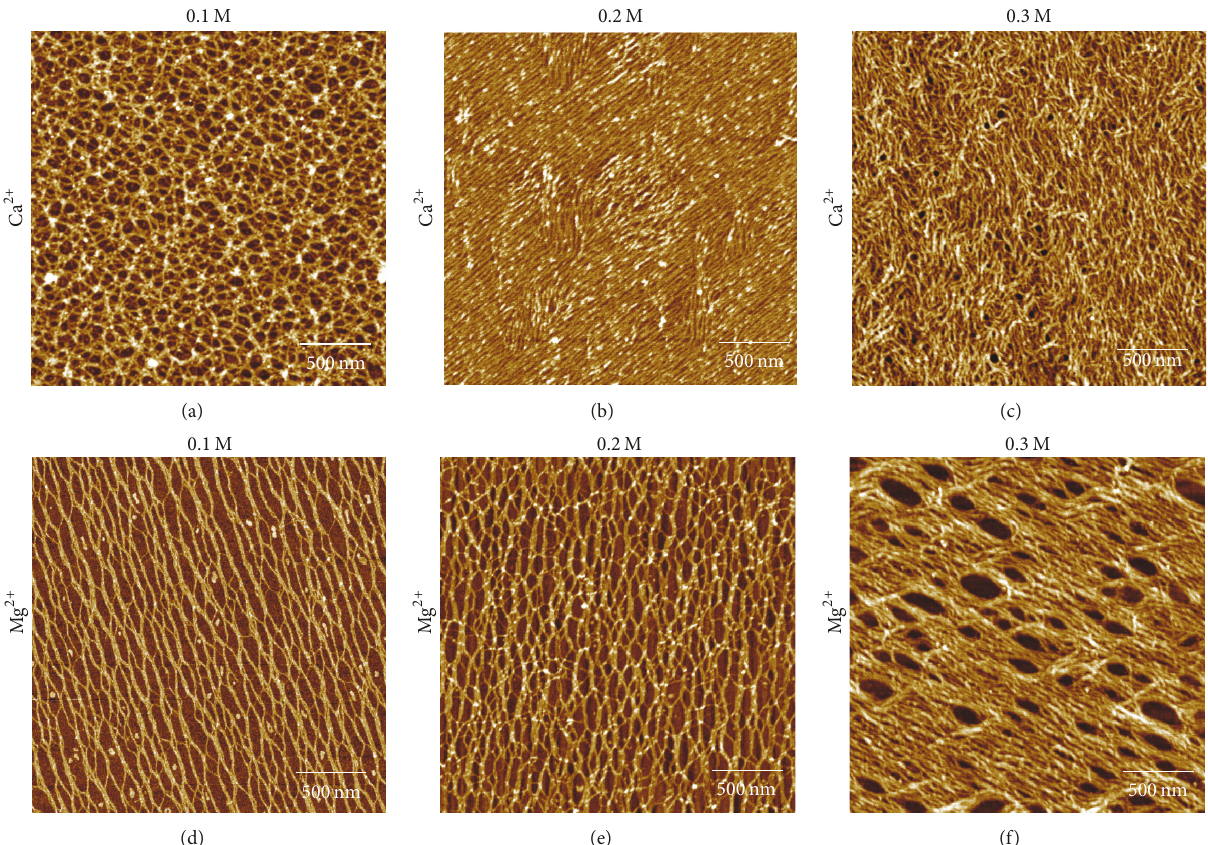
Figure 3: Typical AFM height images of collagen self-assembly in CaCl 2 and MgCl 2 solution with different ions concentration in 512 × 512 pixels: (a, d) 0.1M; (b, e) 0.2 M; (c, f) 0.3